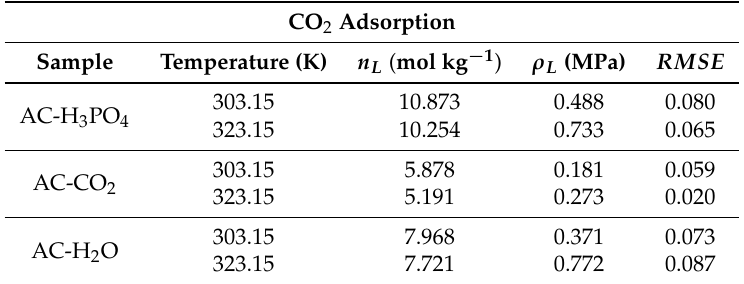
Table 4. Langmuir fitting parameters for the CO 2 adsorption